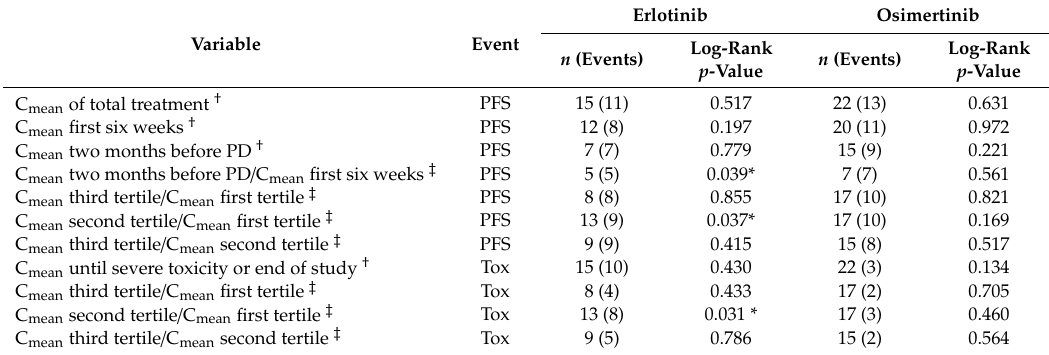
Table 4. Kaplan-Meier analysis to correlate (changes in) C mean during treatment with PFS and toxicity.